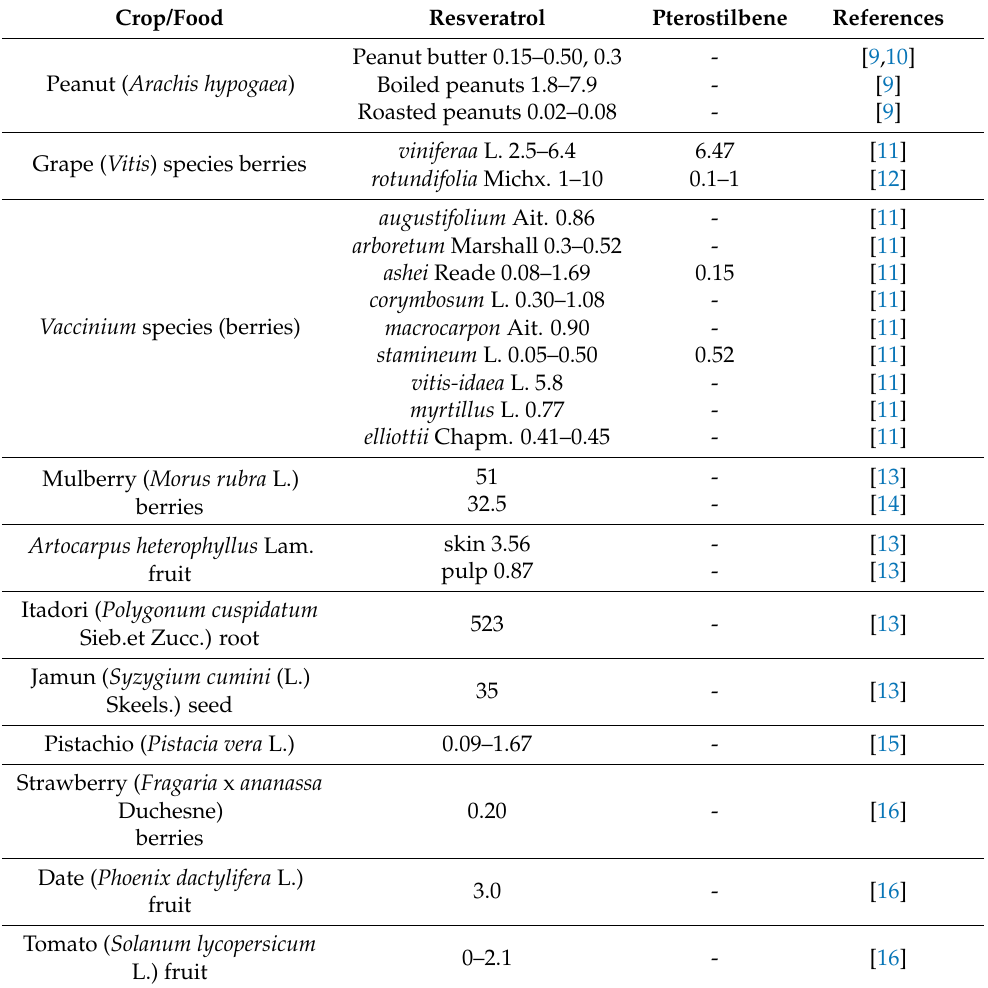
Table 1. Resveratrol and/or pterostilbene concentrations in some food crops and foods derived from these crops. All values are µ g/g dry wt. A dash (-) means that this value was not